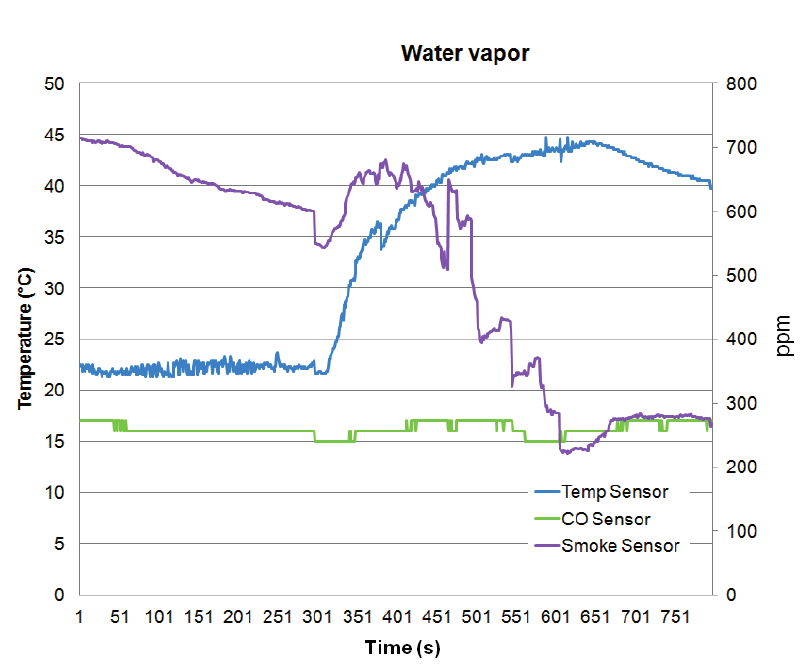
Figure 13. Water vapor